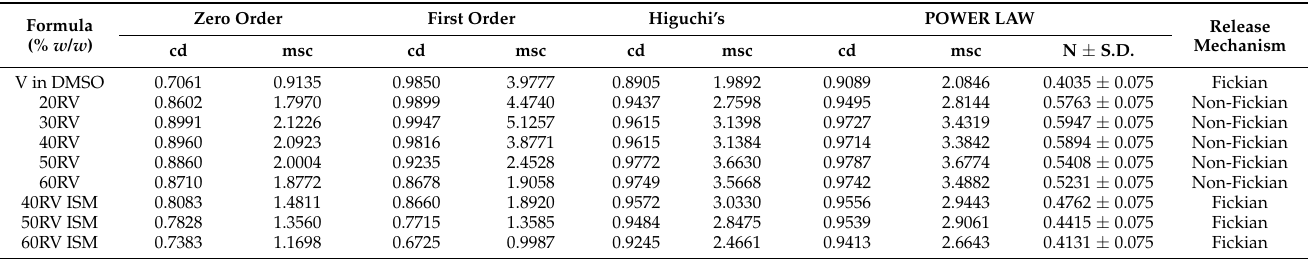
Table 4. Comparison of the degrees of goodness-of-fit from curve fitting the release profiles of vancomycin HCl released from rosin-based ISG and ISM in PBS pH 6.8 using the dialysis membrane method for the different release